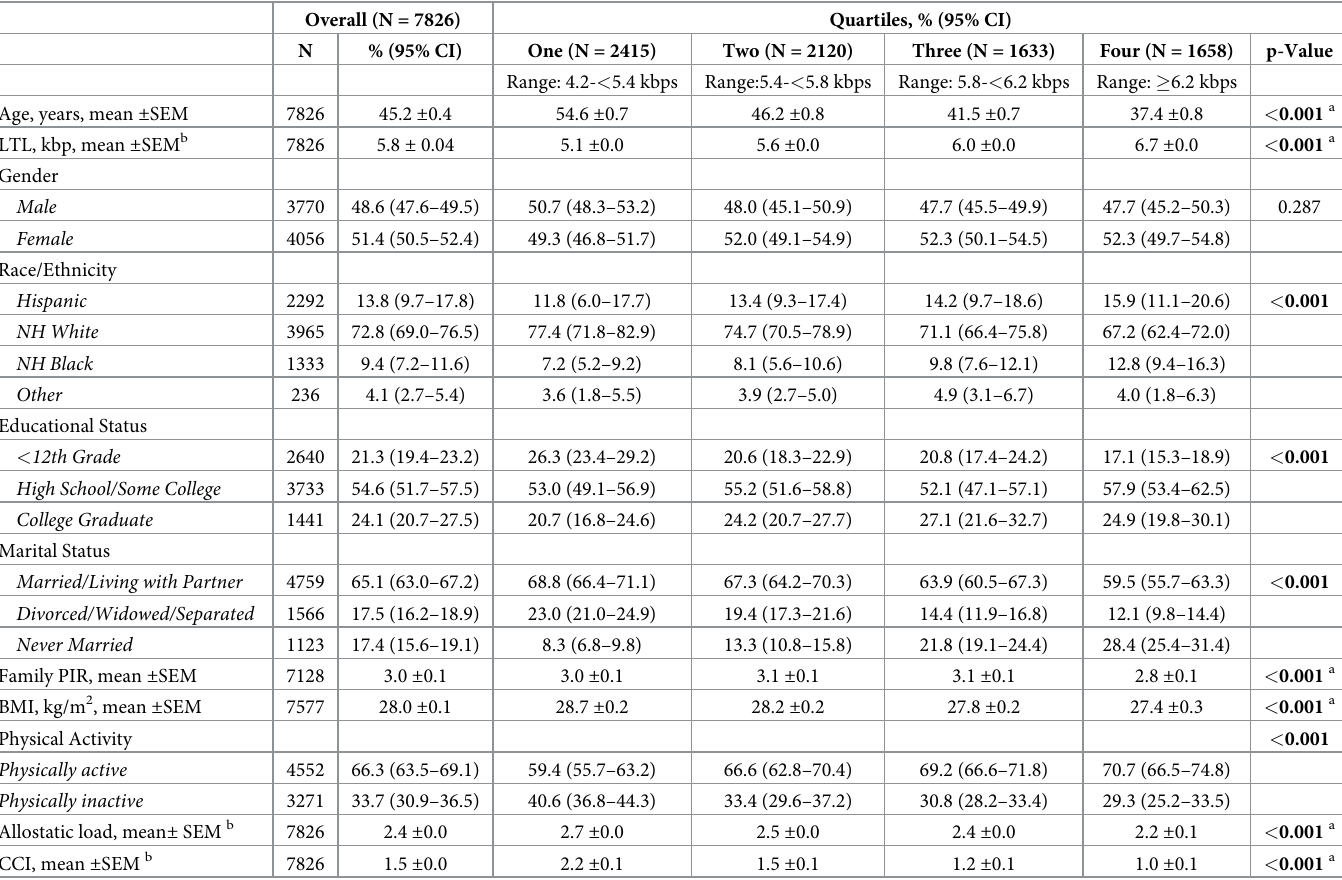
Table 1. Socio-demographic characteristics of the study participants by quartiles of leukocyte telomere length- NHANES